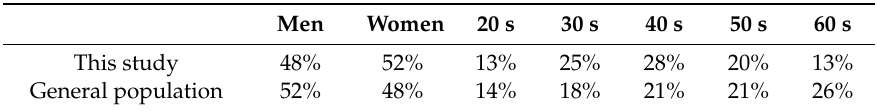
Table 1. Distributions of participants in this study and in the general population of Fukushima Prefecture in August